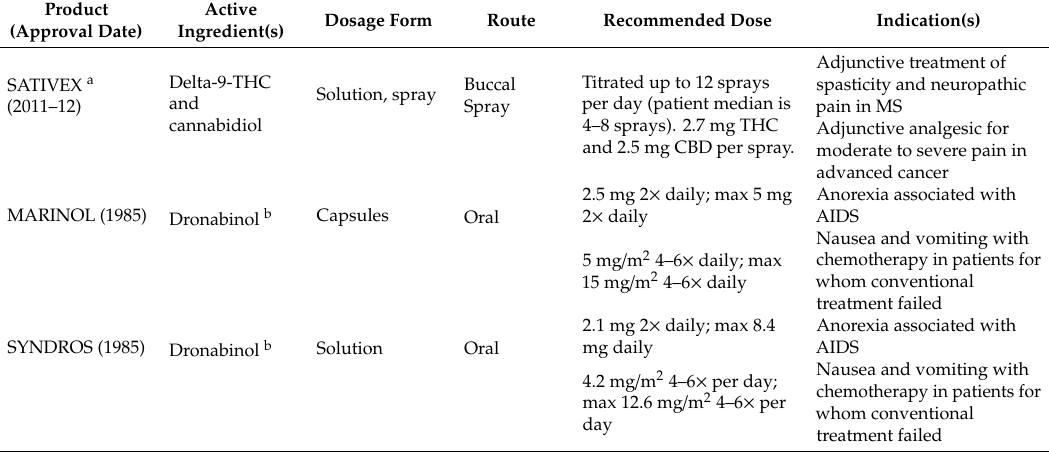
Product information for cannabis-derived pharmaceutical products that contain tetrahydrocannabinol